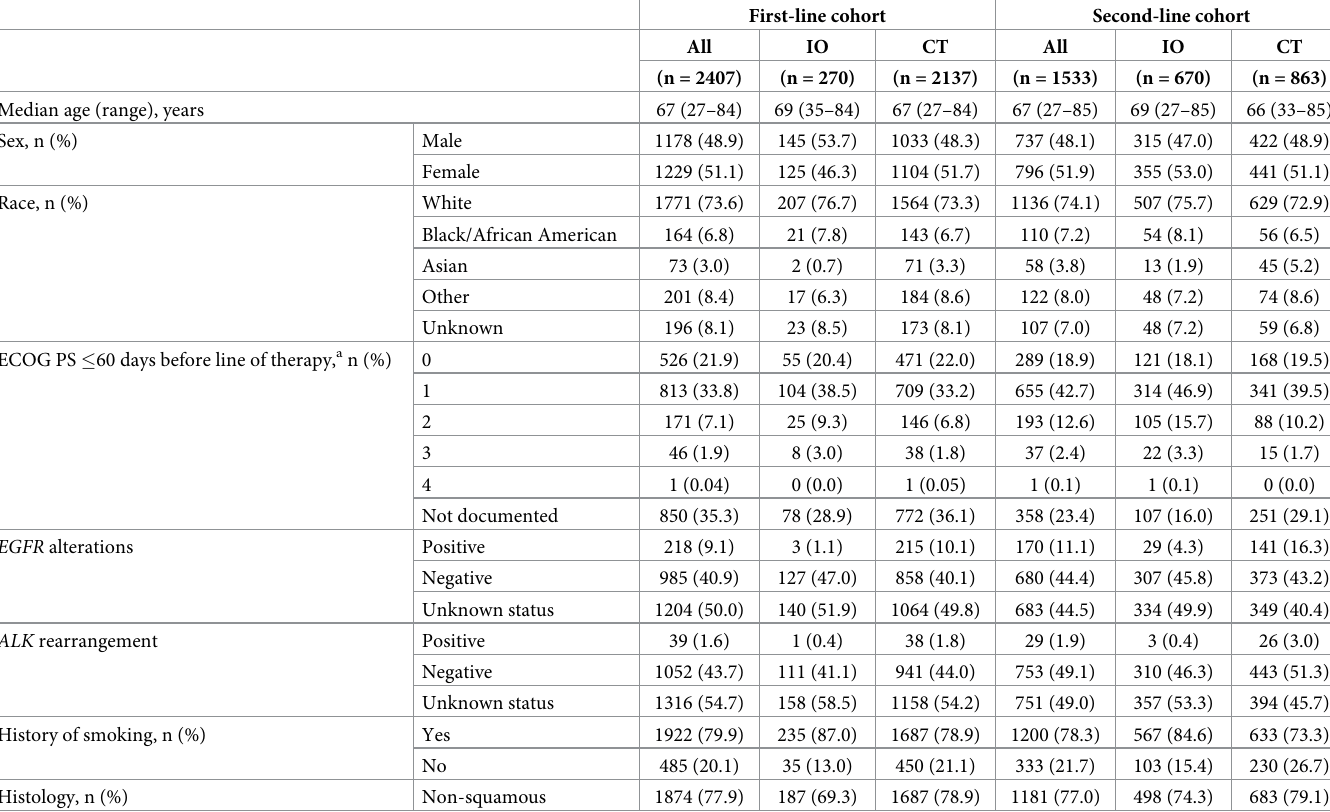
Table 1. Patient characteristics at start of line of therapy.